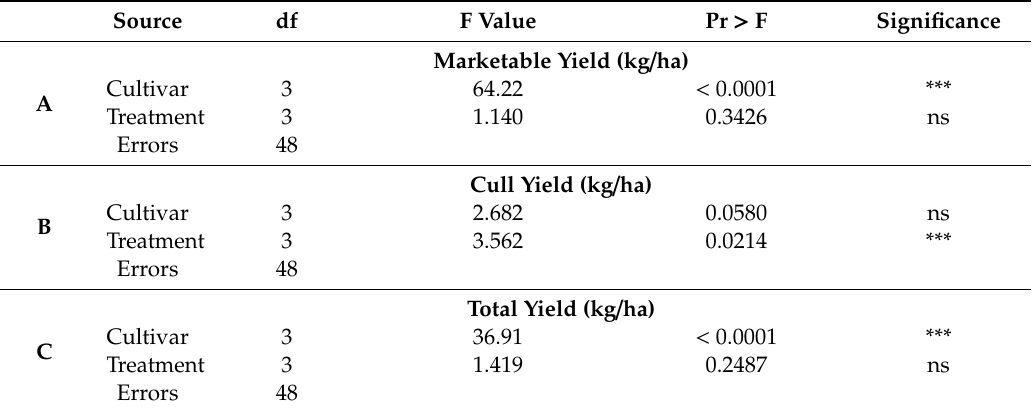
Table 4. ANOVA results for Marketable, Cull, and Total sweetpotato